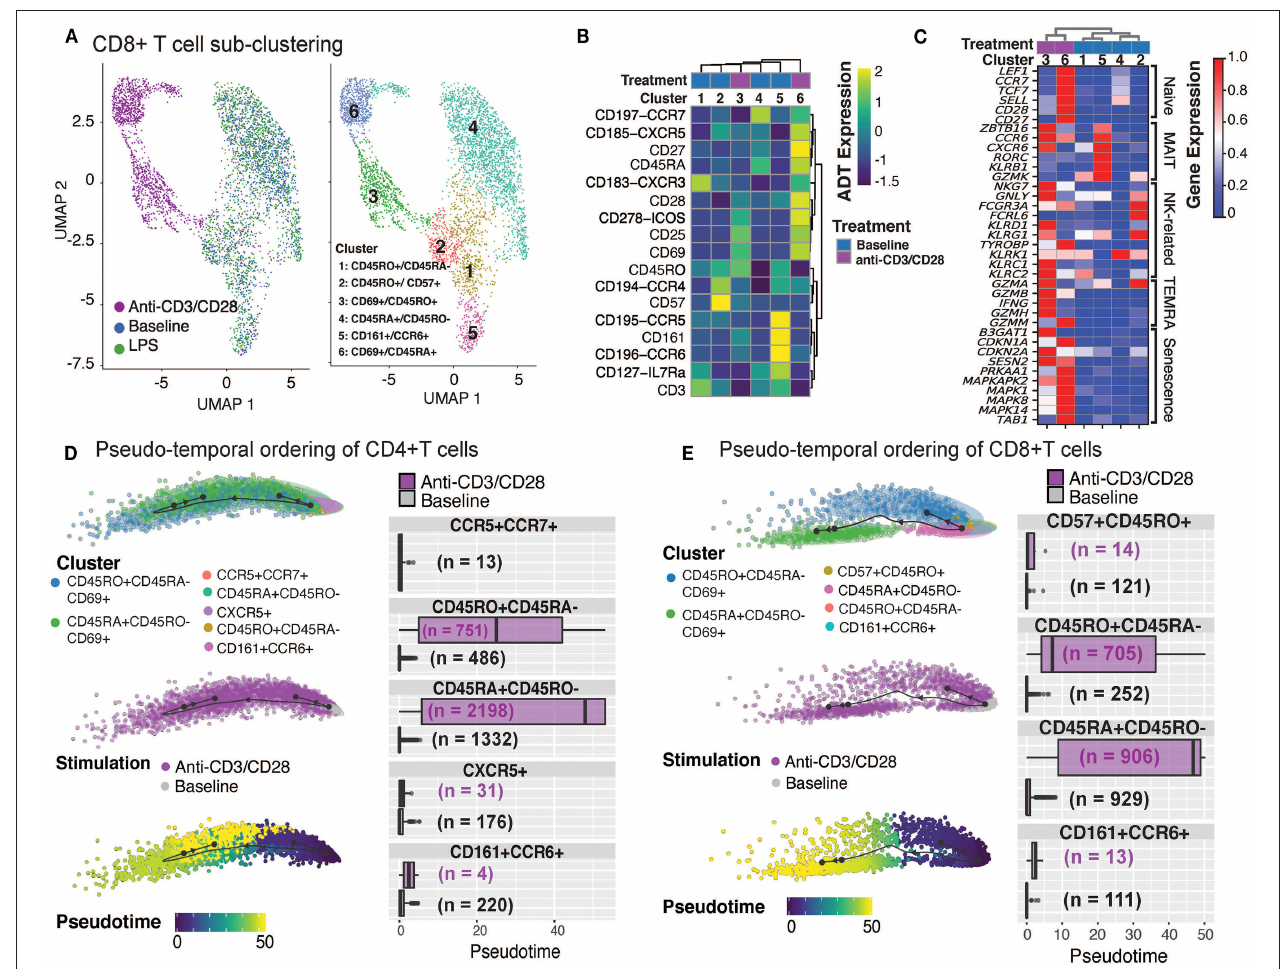
FIGURE 3 | Annotation of CD8 + T cell subsets and trajectory inference. (A) Unsupervised clustering of CD8 + T cells from all conditions reveals a separation of anti-CD3/CD28-stimulated cells from all others. Dimension reduction plot with CD8 + T cells colored by their resultant cell-type identity. (B) Average scaled expression of protein markers used to also identify CD8 + T cell subpopulations. (C) Average scaled expression of marker genes associated with naïve, MAIT, NK, TEMRA, and senescence functions. Pseudo-temporal ordering of (D) CD4 + and (E) CD8 + T cells at baseline and anti-CD3/CD28 conditions. Boxplots show the distributions of pseudotime states for each of the baseline/activated T cell